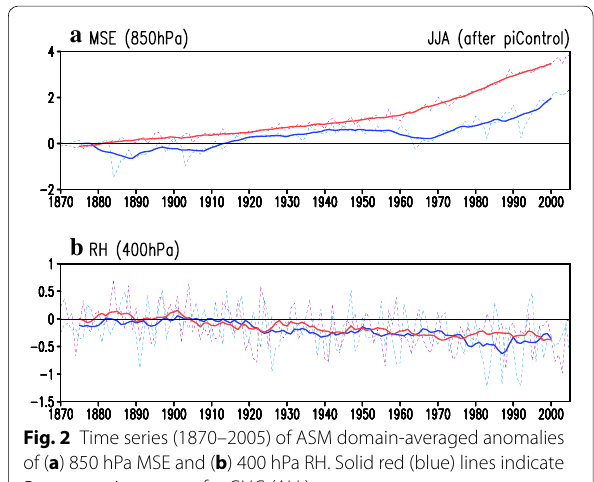
Fig. 2 Time series (1870–2005) of ASM domain‑averaged anomalies of ( a ) 850 hPa MSE and ( b ) 400 hPa RH. Solid red (blue) lines indicate 5‑year running means for GHG